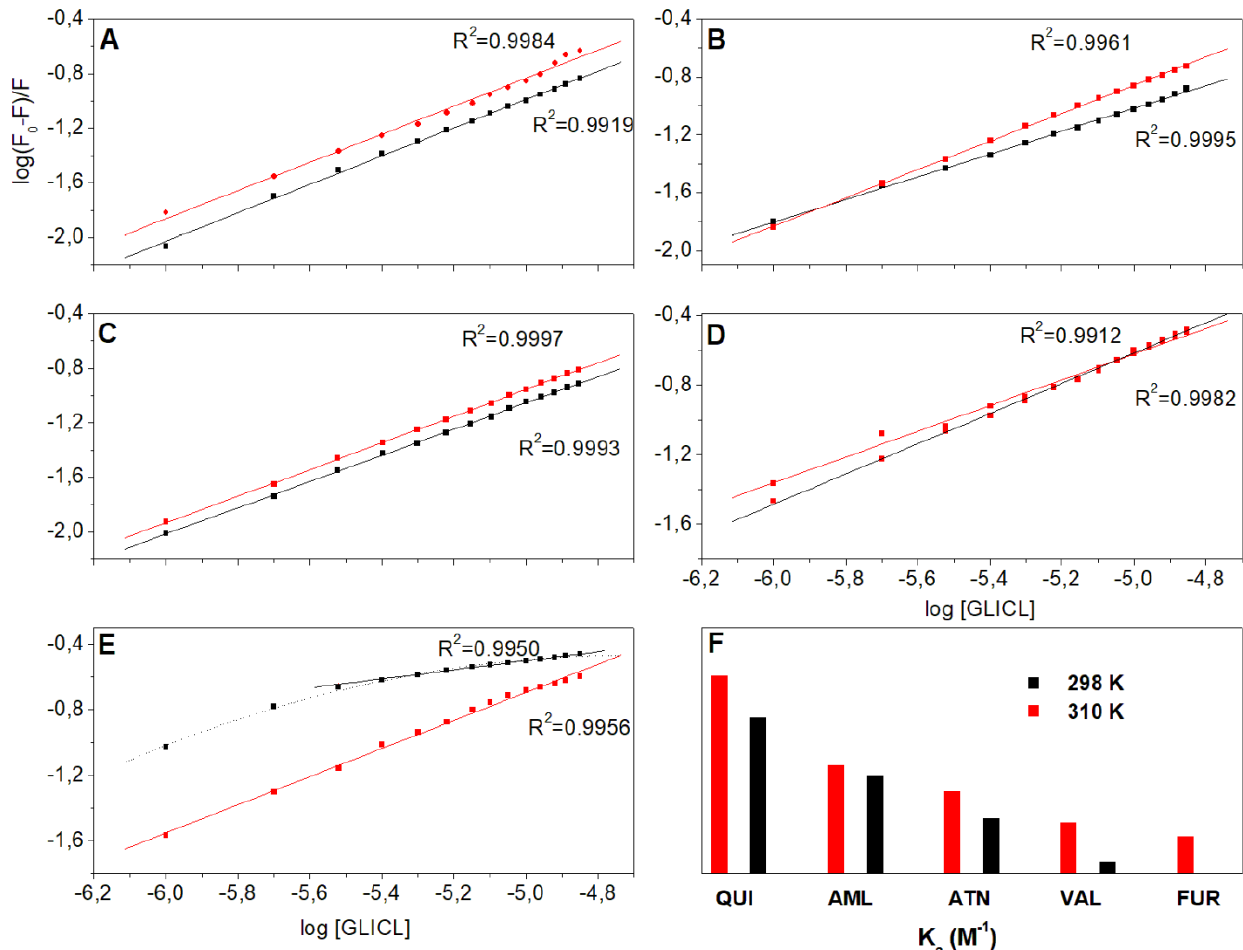
Figure 3. ( A – E ) The double-logarithm plots of the gliclazide quenching effect on BSA fluorescence in the presence of different DRUG ligands: QUI ( A ), AML ( B ), ATN ( C ), VAL ( D ), and FUR ( E ) at 298 and 310 K, λ ex = 280 nm. ( F ) Graphical representation of calculated K a values of BSA–GLICL complex in the presence of different DRUG ligands at different